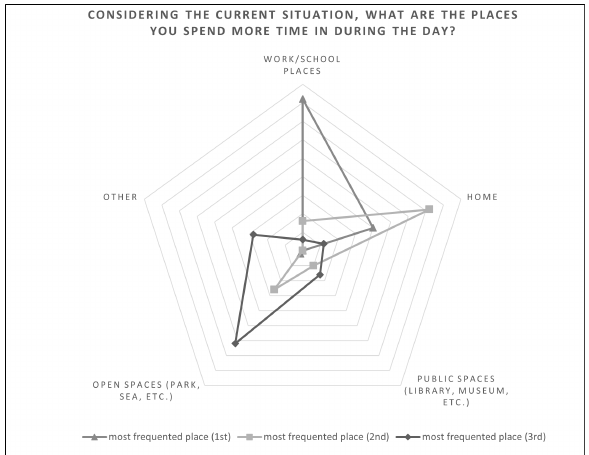
Figure 7: Typology and ranking of the most frequented places during the day, referring to the current situation.